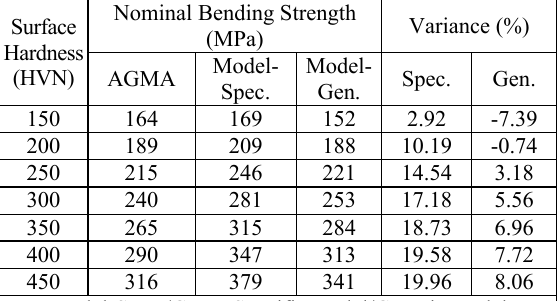
Table 2: Nominal Bending Strength Estimate Comparison for Grade 1 Steel Materials Surface